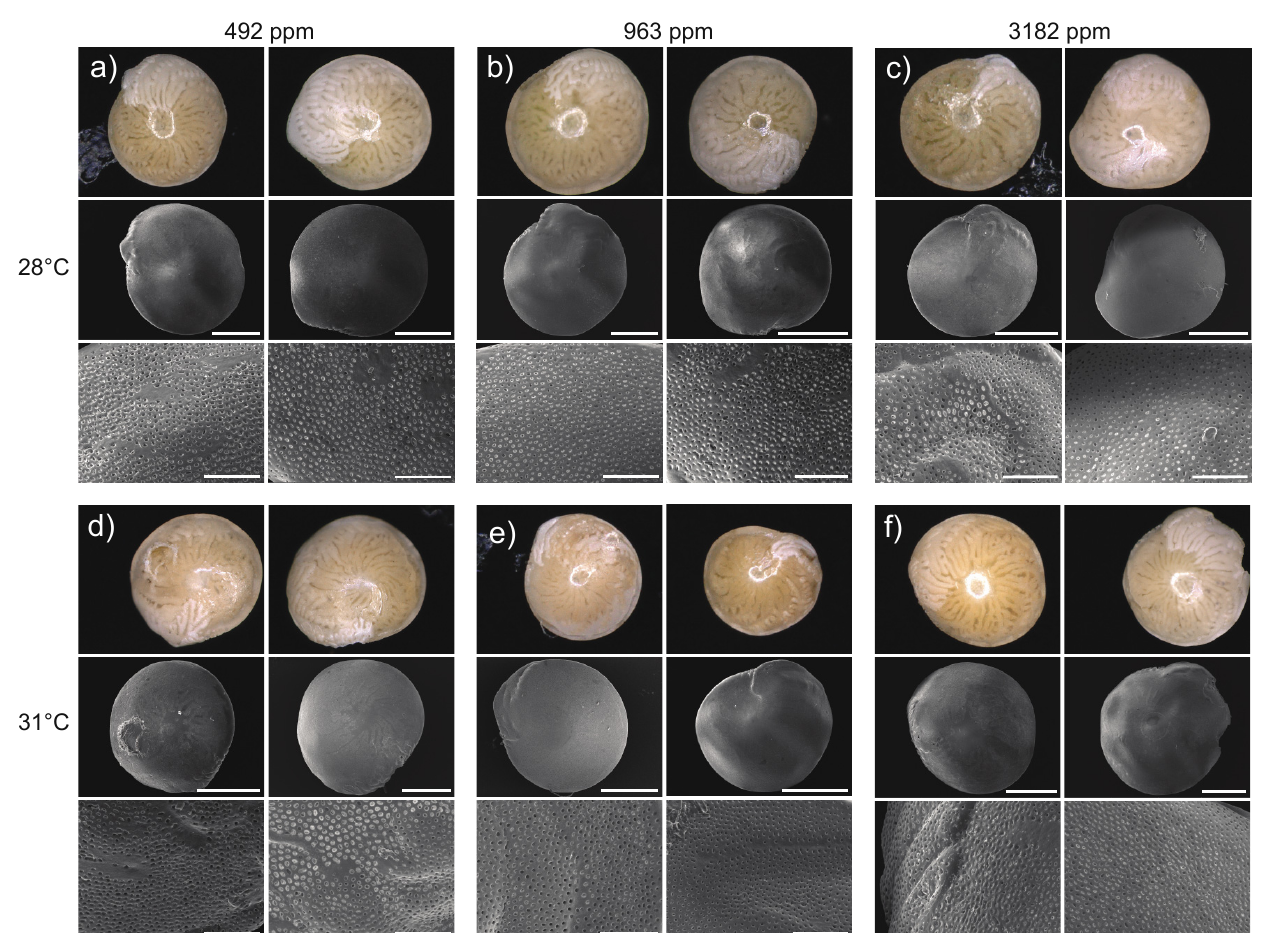
Figure 4. Representative images of Amphistegina lobifera after 8-week exposure to elevated p CO 2 (control = 492 ppm, a , d ; moderate = 963 ppm, b , e ; high = 3182 ppm, c , f ) crossed with temperature (28 °C, a – c ; 31 °C, d – f ). Entire specimens shown via light microscopy (upper rows) and low-magnification SE imaging (middle rows), with the terminal chamber shown via high-magnification SE imaging. Scale bars in the full-specimen images represent 500 µm, while bars in high- magnification images represent 50 µm.